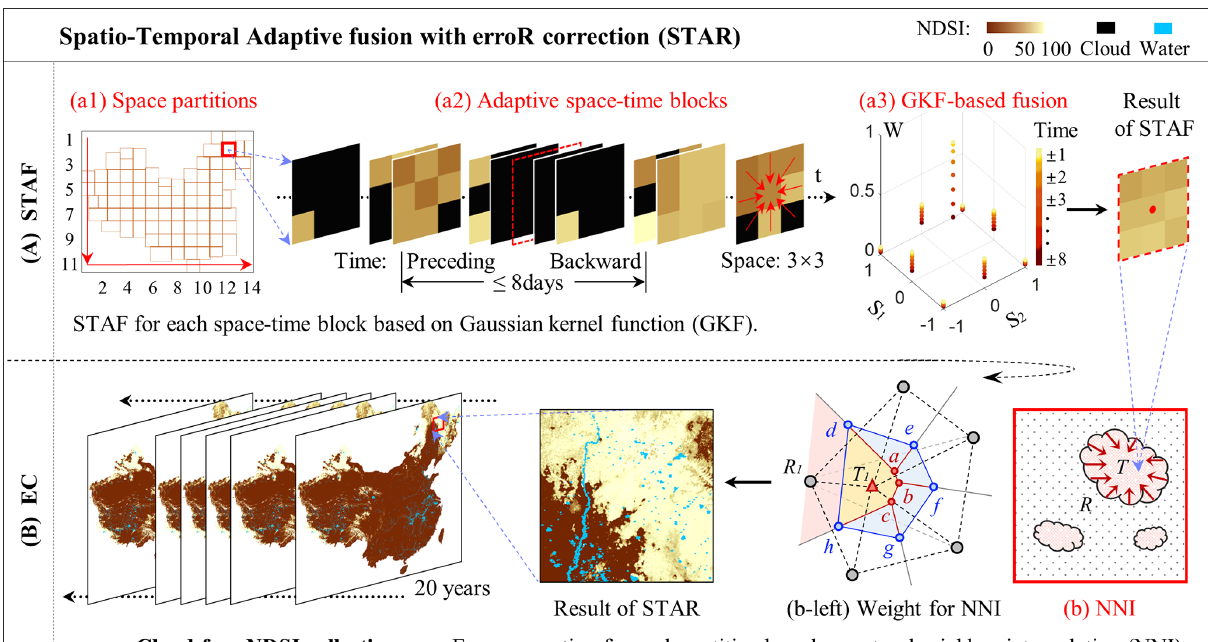
Figure 3. Detailed flowchart of the Spatio-Temporal Adaptive fusion with erroR correction